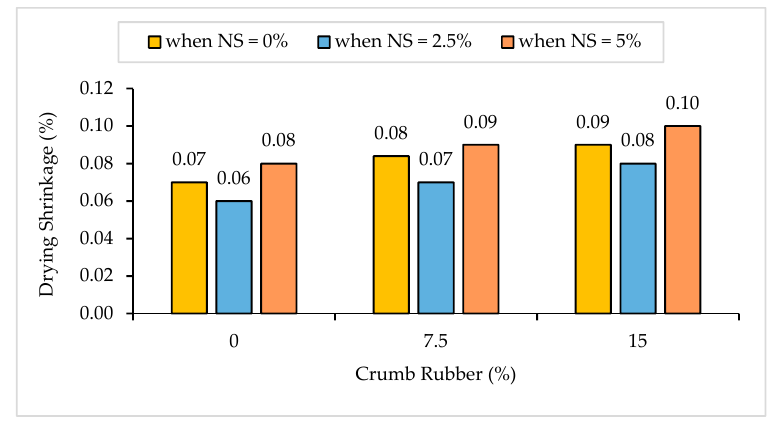
Figure 8. Drying shrinkage of NS-CRM mixes at 28 days.